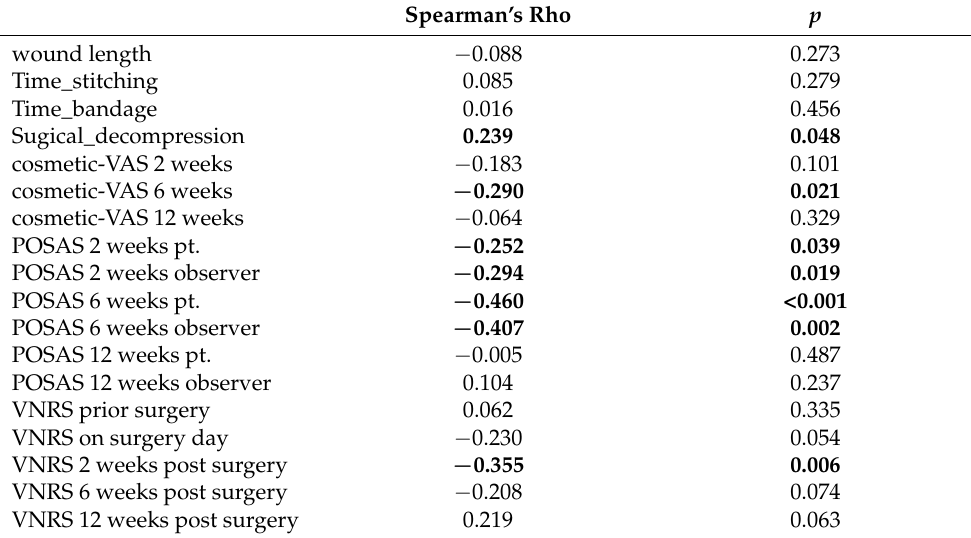
Table 3. Correlation analysis between body mass index (BMI) and outcome scores in a subgroup of subjects with glue wound closure ( n = 50); Spearman’s correlation, one-tailed, significant correlations are